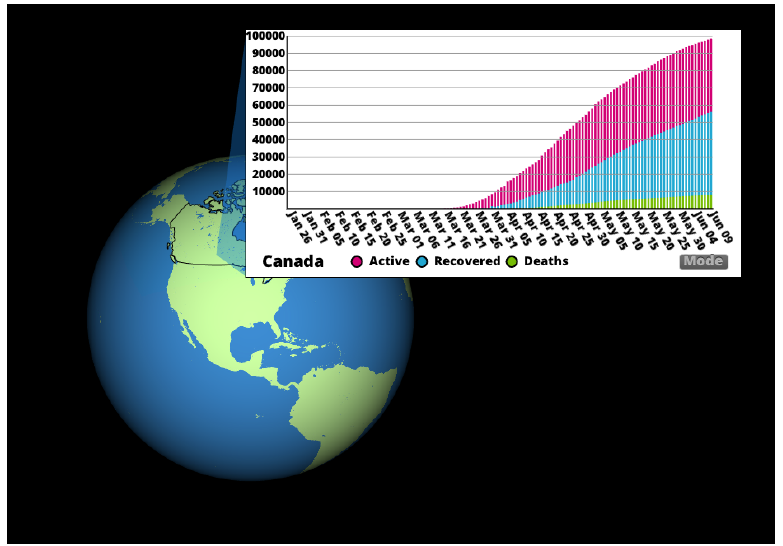
Figure 3. An example of the COVID-19 Visualization project, displaying Canadian data in a bar chart.